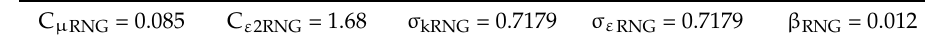
Table 2. Constants of the RNG k- ε turbulence model.